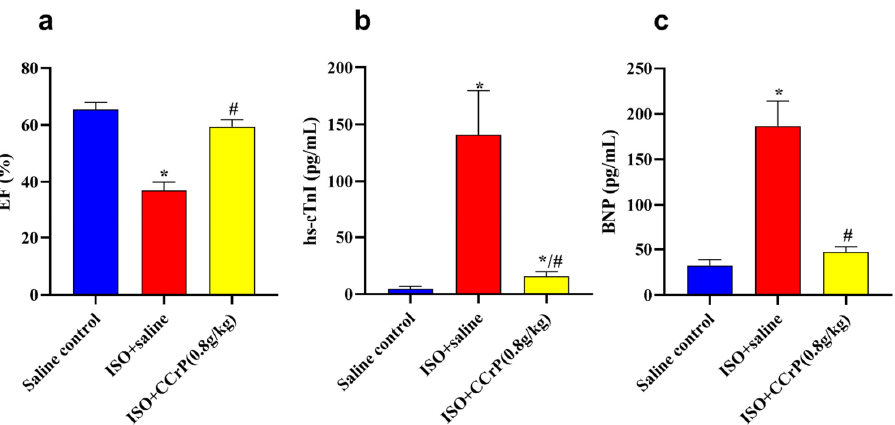
Figure 7. ( a ) ISO/saline showed a significant reduction in EF%, which was restored to normal levels due to the therapeutic treatment of CCrP at the dose of 0.8 g/kg/day; CCrP treatment also significantly reduced levels of TnI ( b ) and BNP ( c ). Data are presented as mean ± S.E.M. of 4–6 rats. *: